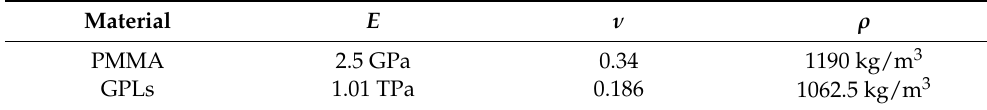
Table 1. Material properties of the polymer [35] and GPLs [6].